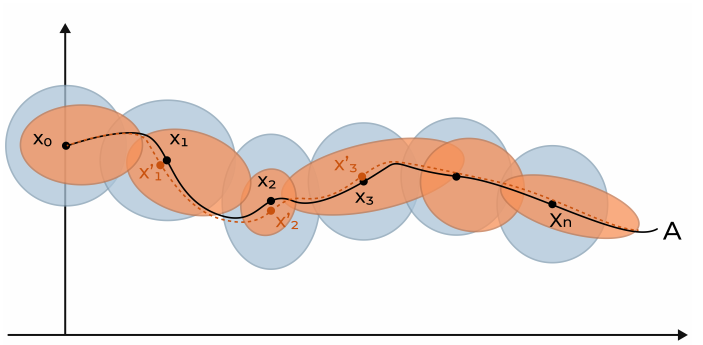
Figure 4. Collection of reduction points x (cid:48) earization points x 0 , x 1 , x 2 and x 3 in a 2D state-space. Orange circles denote suitable regions for use for each reduced-order model, whereas the orange dashed line represents an approximation to the training trajectory